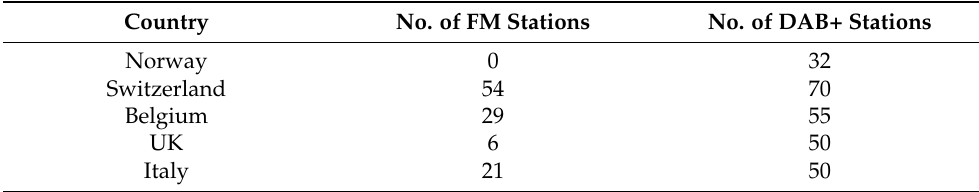
Table 4. Number of national stations in FM and